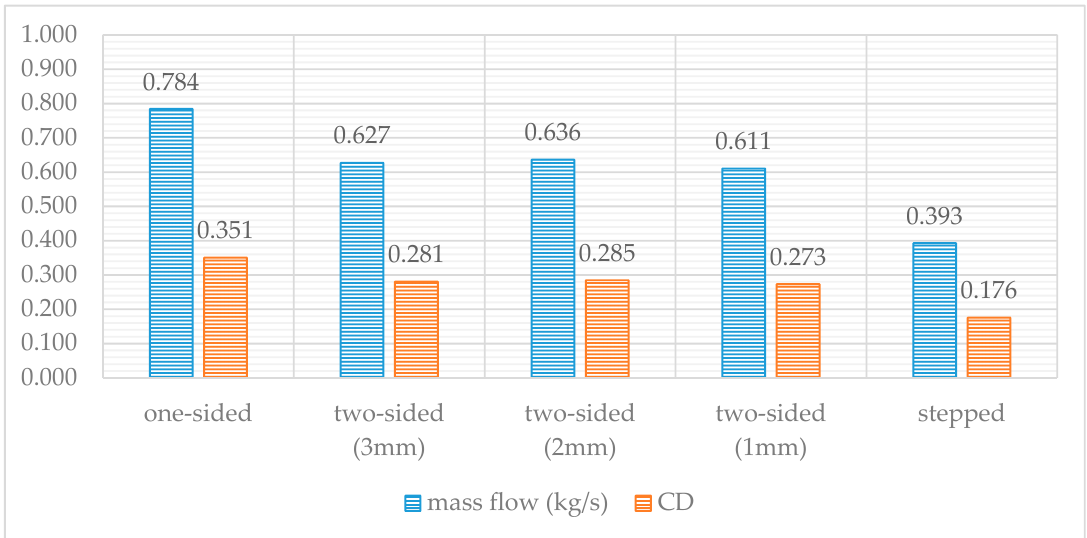
Figure 12. Influence of geometry configuration on the computed discharge coefficient and the mass flow rate.